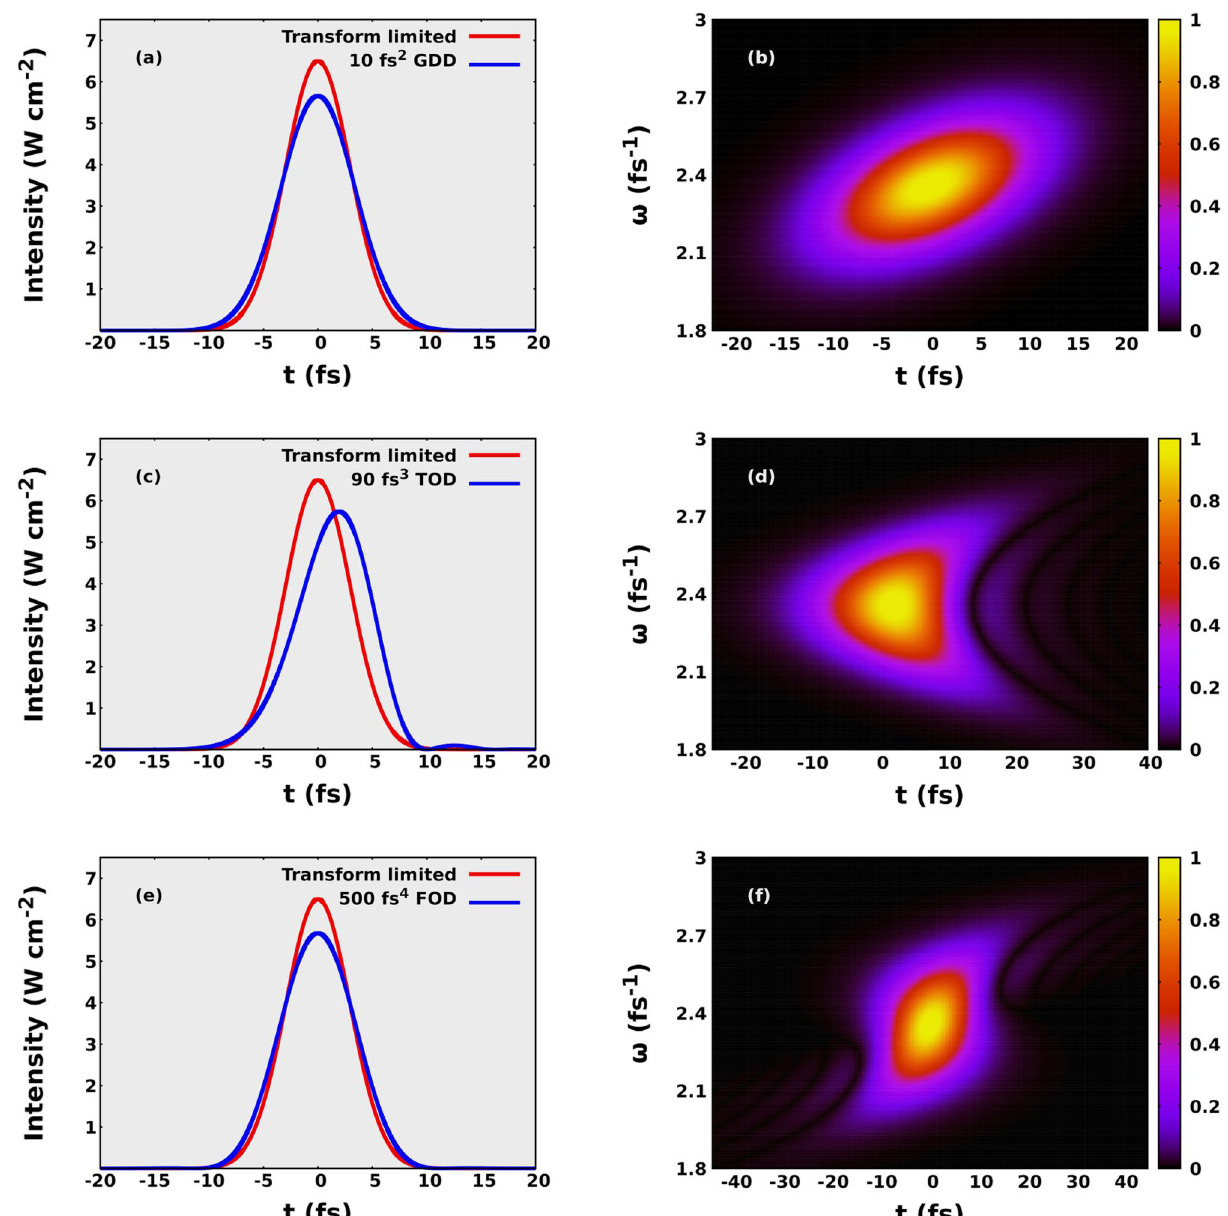
Figure 1. The effect of GDD, TOD and FOD on an ultrashort pulse of 7 fs FWHM and a carrier frequency of 800 nm. On the left side the intensity as a function of time is depicted. The curves denote the shape of the pulses. The red lines show the TL pulses and the blue curves denote pulses shaped with 10 fs 4 and 500 fs FOD (e). In the right column the corresponding Wigner distributions are plotted for 10 fs 3 4 90 fs TOD (d) and 500 fs FOD